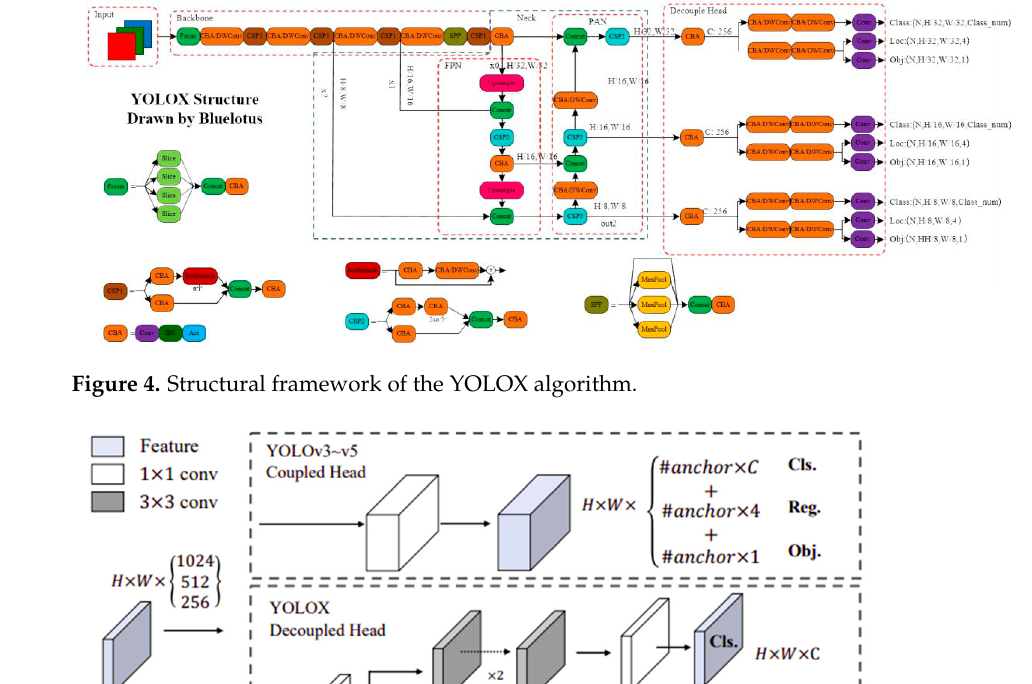
Figure 4. Structural framework of the YOLOX algorithm.